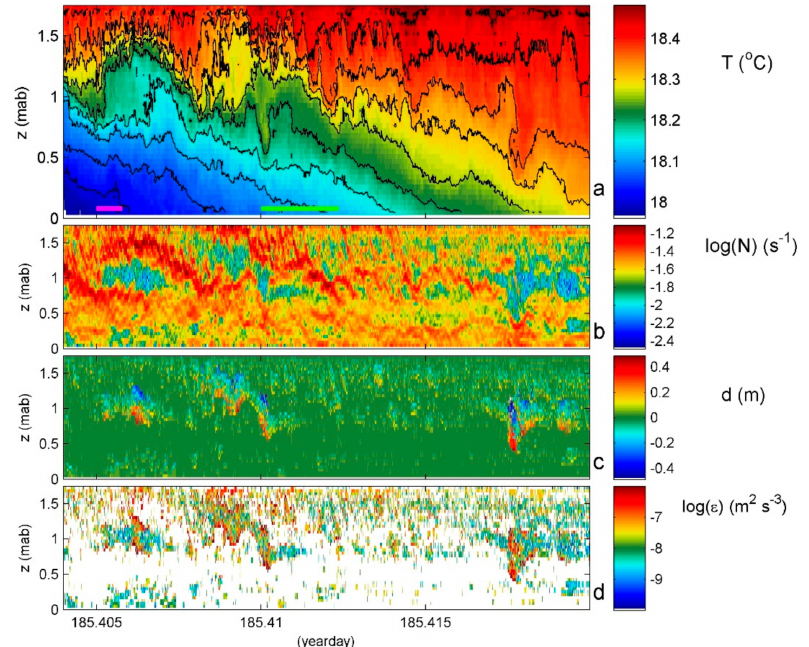
Figure 8. Twenty-three minutes and 1.6 m detailed example of the diurnal warming phase of the waters near an inland sea beach, ‘Ceres’ in the Wadden Sea off Texel, NL. Until day 185.41 (~10 UTC) the tide was incoming and, coincidentally, the weather was very calm (wind speeds < 3 m s − 1 ; surface wave heights < 0.05 m) with overcast skies. After that, sunshine, wind speed (up to 8 m s − 1 ), and surface wave height (up to 0.2 m) increased. ( a ) Observed conservative temperature with missing sensors interpolated (see text) and black contours every 0.05 ◦ C. The green and purple horizontal bars indicate the maximum and mean buoyancy periods, respectively. ( b ) Buoyancy frequency. ( c ) Displacements between data in reordered profiles. ( d ) Dissipation rate computed from data in b and c.